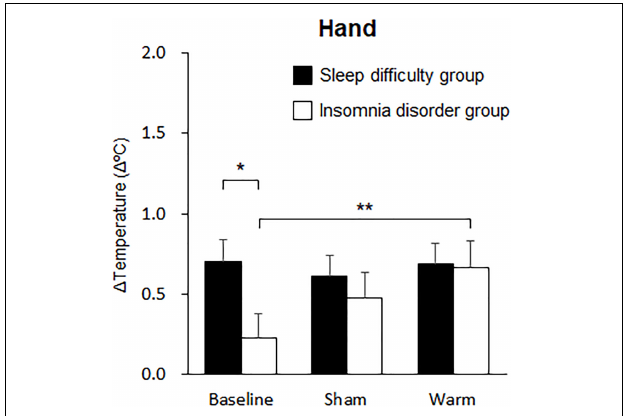
FIGURE 5 | Comparisons of changes in hand skin temperature over 10 min. The black bars represent the sleep difficulties group, and the white bars represent the insomnia disorder group. Bars and error bars represent the mean ± standard error of the mean (SEM). * p < 0.05, ** p < 0.01.